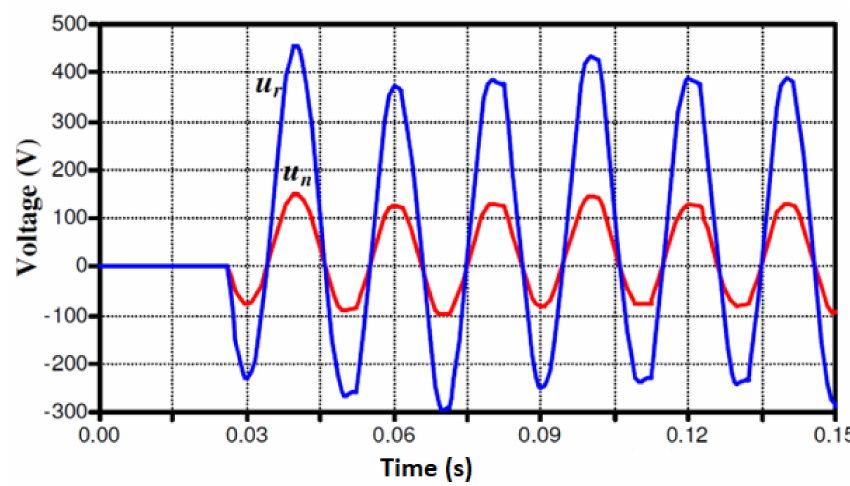
Figure 11. Measure neutral ( U n ) , and residual voltage ( U r ) .